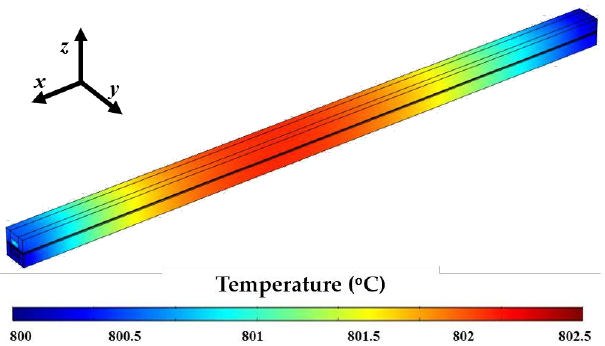
Figure 6. Three-dimensional temperature distribution on an entire unit cell stack in the reference case (case 1) having an electrolyte thickness of 100 μm and an operating temperature of 800 °C.